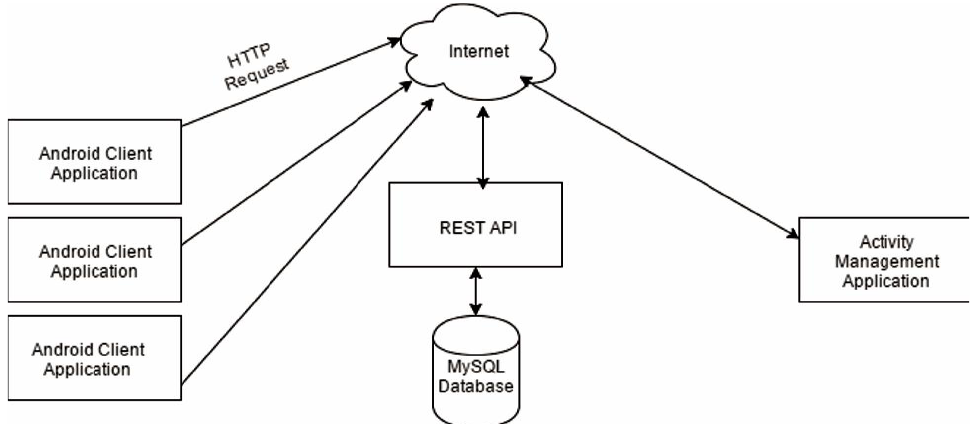
FIG. 4. USE-CASE DIAGRAM FOR OVERALL SYSTEM